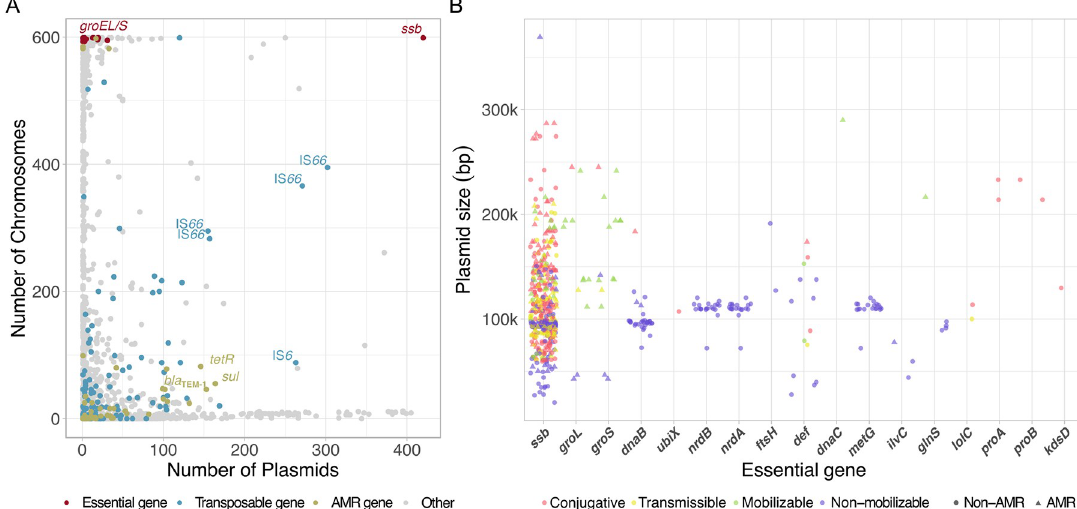
Fig 1. The distribution of plasmid-encoded essential genes on plasmids and chromosomes. A , The distribution of Escherichia protein families on plasmids in chromosomes (in grey). Essential genes (red) are found in most of the chromosomes and rarely on plasmids, with ssb as an exception. Transposable elements (blue) are frequent on both chromosomes and plasmids. IS 66 is the most widely spread gene in Escherichia strains. IS 66 was split into several protein families in our analysis, which are depicted by multiple data points. Antibiotic resistance (AMR) genes (yellow) are presented for comparison. The AMR genes can be roughly divided into two groups: the first group aligns along the y-axis hence it is more frequently found on chromosomes; those chromosome-encoded AMR genes are typically related to persistence and resilience functions. The second group aligns along the x-axis hence it is more frequently found on plasmids; those plasmid-encoded genes are typically related to antibiotics resistance functions (Wein et al. 2020). B , Distribution of plasmid size, mobility group and AMR for plasmids encoding an essential gene. Most of the ssb -coding plasmids are conjugative (red) while the majority of groEL/S coding plasmids are mobilizable (green). The remaining essential genes are encoded on plasmids that are often non-mobilizable (and non-AMR)